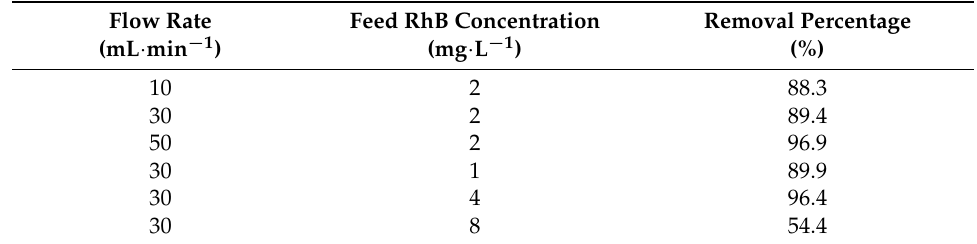
Table 1. Influence of feed flow rate and initial RhB concentration on the photocatalytic degradation